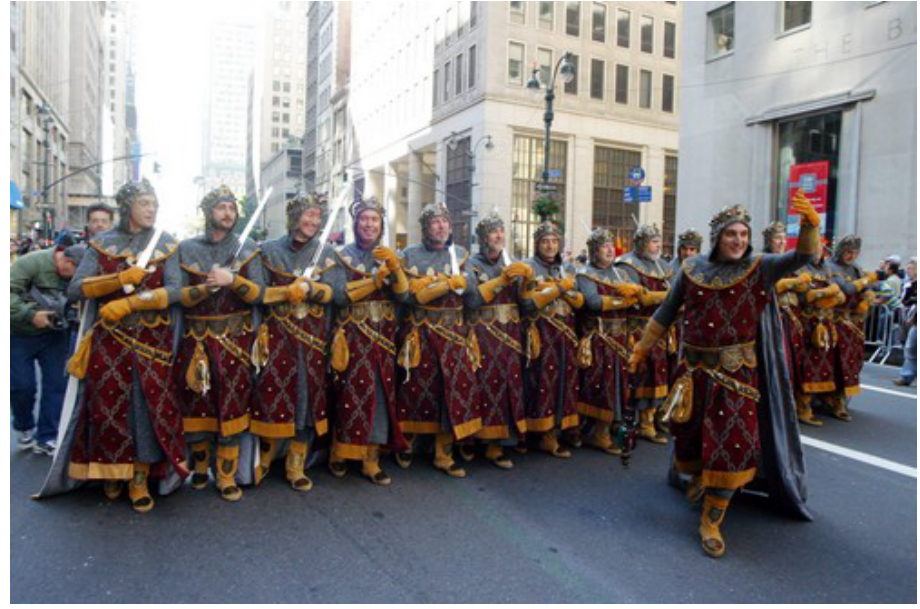
Photo by Miguel Rajmil/EFE